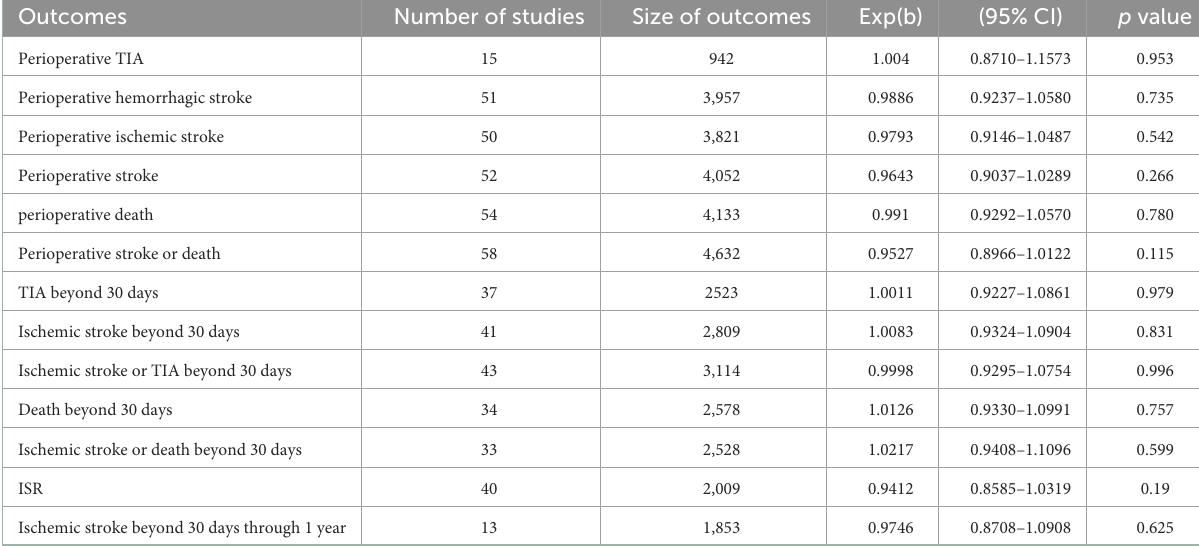
TABLE 5 Univariate meta-regression analyses based on publication time. Outcomes